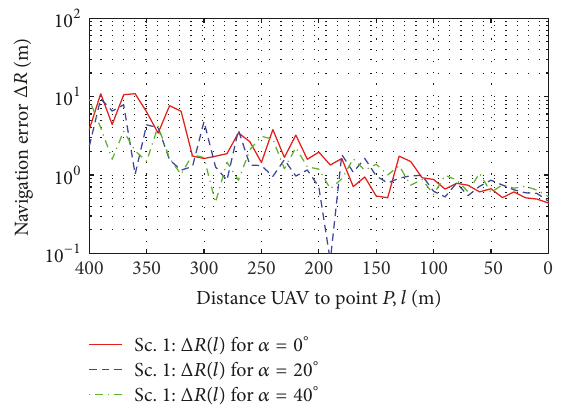
Figure 7: Navigation error for 𝛼 = 0 ∘ , 𝛼 = 20 ∘ , and 𝛼 = 40 ∘ – Sc.